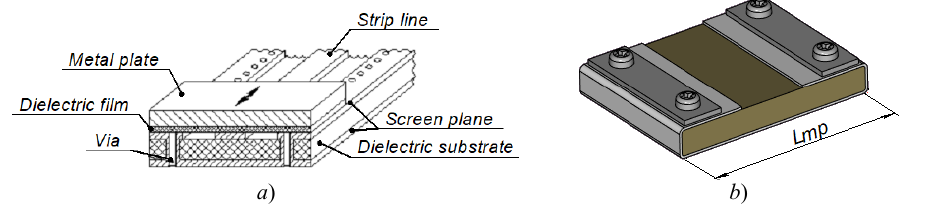
Fig. 4. Impedance transformer: a – principle of operation; b – construction of movable